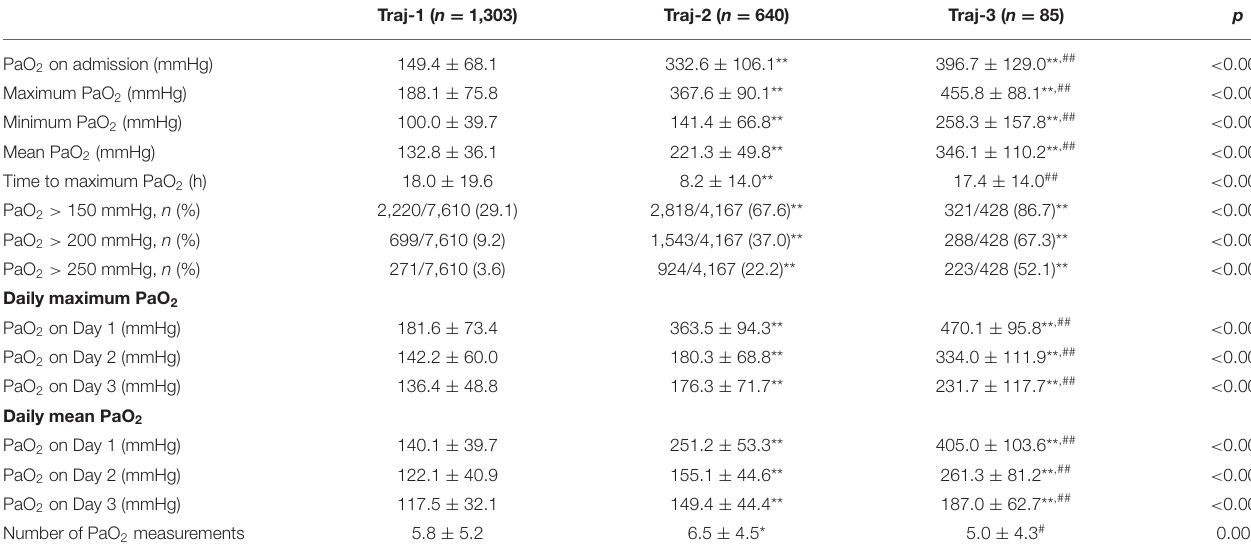
TABLE 2 | Partial pressure of oxygen indexes according to the partial pressure of oxygen trajectory.